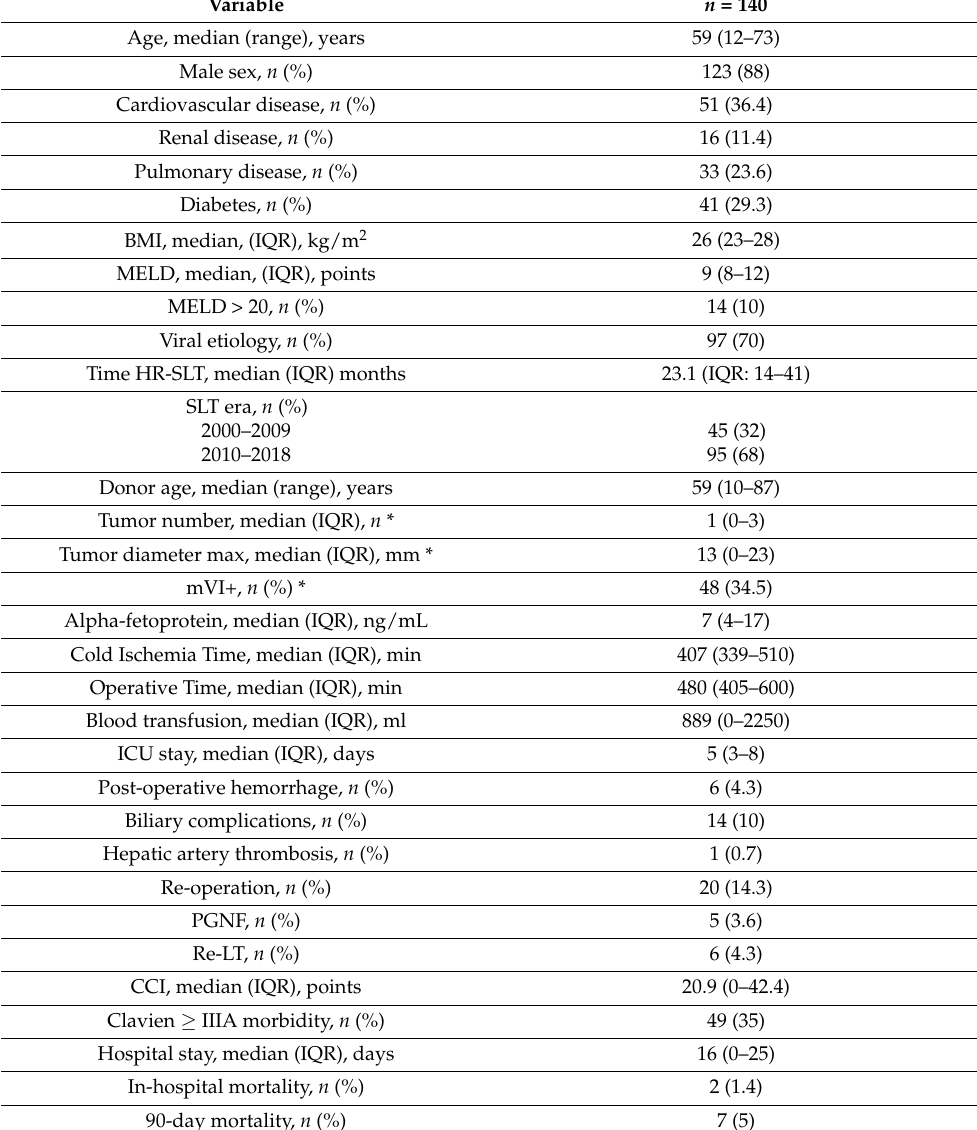
Table 2. Characteristics of the patients at the time of secondary liver transplantation